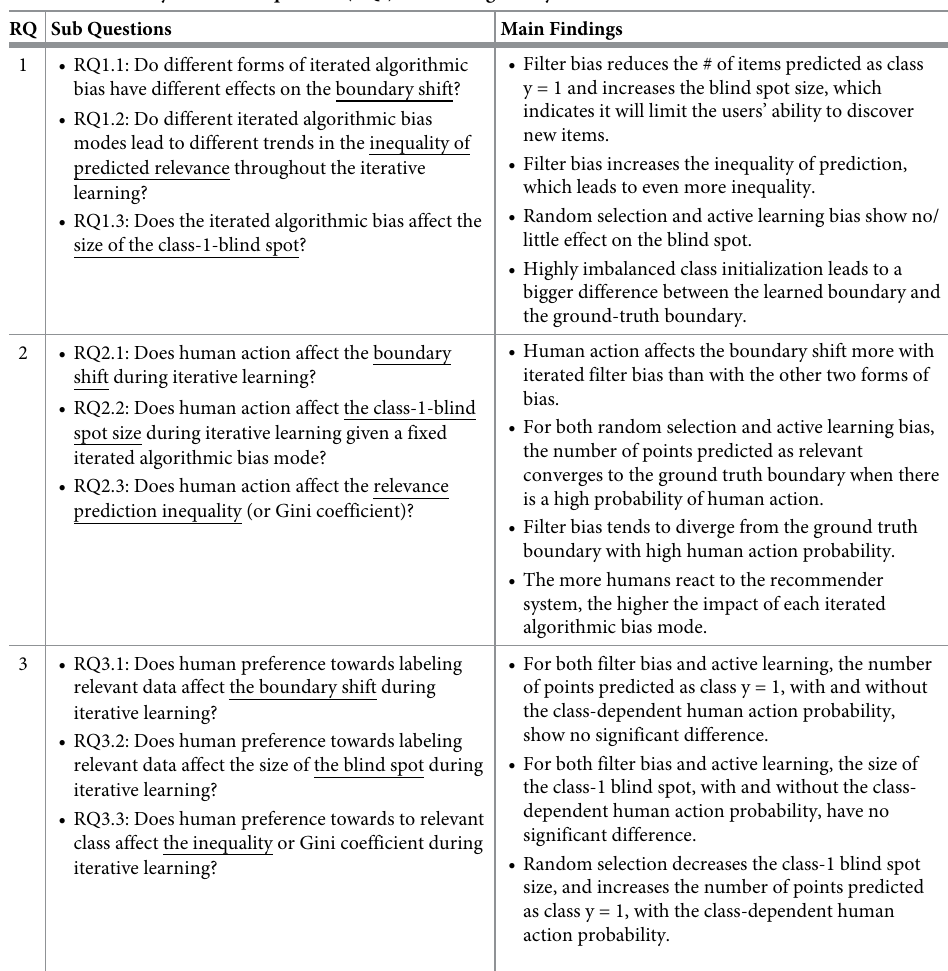
Table 19. Summary of research question (RQs) and findings for synthetic data.